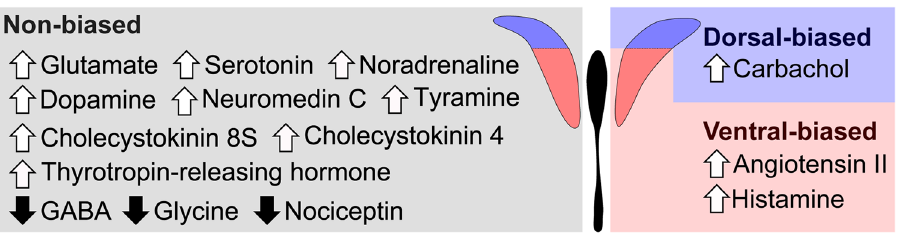
Figure 6. Substances affecting intracellular calcium concentrations in PVN-CRF neurons. Summary of substances which increased or decreased (white upward or black downward arrows shown to the left of each substance, respectively) intracellular calcium concentration in PVN-CRF neurons. Substances listed in the left panel affected both dorsal- and ventral-CRF neurons (non-biased). In contrast, carbachol seemed to mainly affect the dorsal-CRF neurons (dorsal-biased), whereas angiotensin II and histamine mainly affected the ventral-CRF neurons